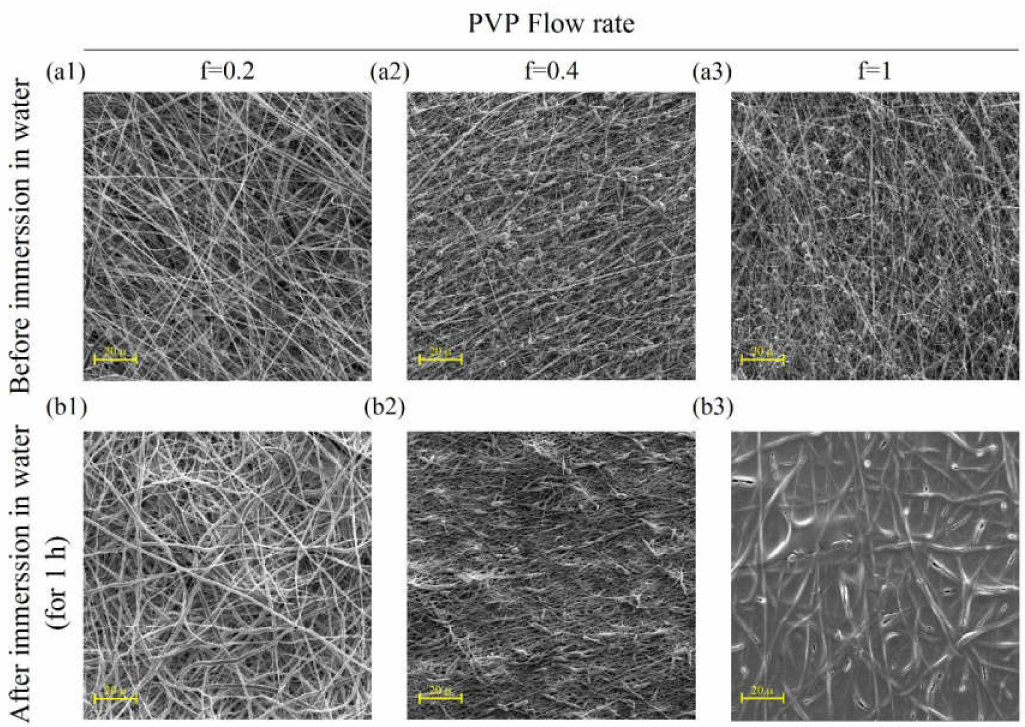
Figure 2. SEM images showing micrographs of co-electrospun PCL (20% w / v, V = 25 KV and D = 15 cm) with polyvinylpyrrolidone (PVP) (25% w / v , V = 25 KV and D = 15 cm) by various flow rates for PVP (ml / h): ( a1 – a3 ) before and ( b1 – b3 ) after immersion in water for